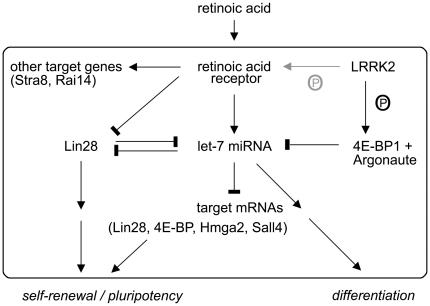
Model of how LRRK2-deficiency may promote retinoic-acid induced neuronal differentiation.Lin28 protein and let-7 miRNA are key regulators of pluripotency and differentiation, respectively. Lower protein levels of LRRK2 and 4E-BP1 in LRRK2+/− ES cells may alleviate suppression of let-7 miRNA function by LRRK2. LRRK2 may also phosphorylate retinoic acid receptors, thereby modulating transcriptional activation/repression of differentiation/stemness factors (for details see Discussion).